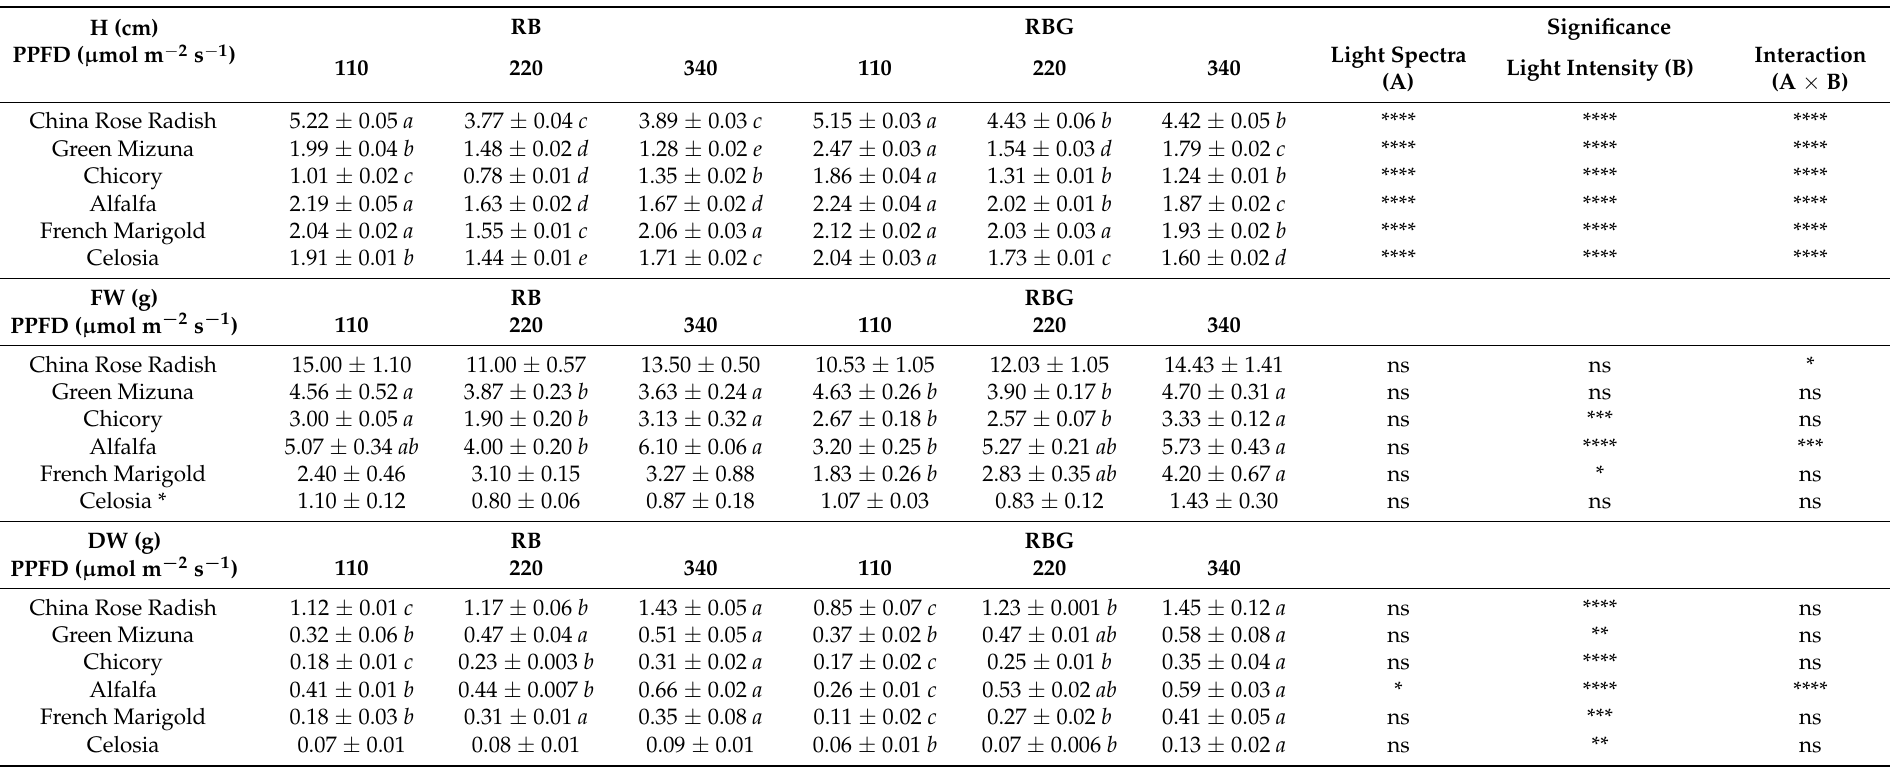
Table 1. Plant growth parameters from six microgreen species affected by different light environments. Values are mean ± SE ( n =10 plants). Data were subjected to two-way analysis of variance with light spectra (RB and RGB) and light intensity (110, 220, 340 µ mol m − 2 s − 1 ) as variables and differences were analyzed by Tukey’s post-hoc. Different letters within each row denote significant differences at p < 0.05. Height (H); microgreens fresh weight (FW); microgreens dry weight (DW). Levels of significance of the parameters assessed for each microgreen species considered where: ns, *, **, ***, ****, are not significant, significance at p < 0.05, 0.01, 0.001, and 0.0001 respectively. When there was not significant A × B interaction, the effect of light spectra (A) and light intensity (B) was evaluated separately using one-way ANOVA and t -test, respectively (Supplementary Table S1). Different letters on the rows within each light spectrum (RB and RGB) indicate significant differences among light intensity (Tukey’s test, p <